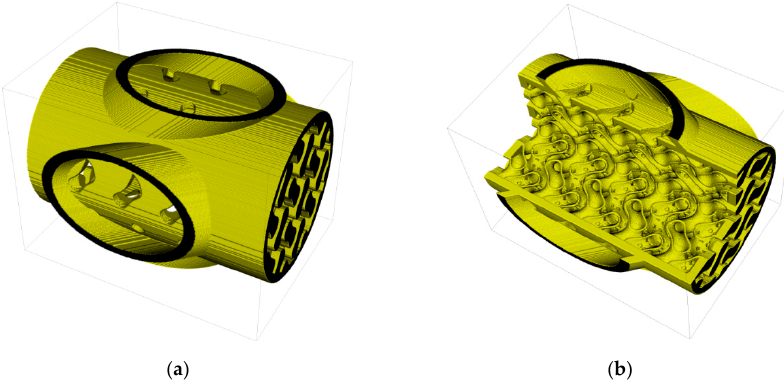
Figure 4. Housing of the gyroid structure ( a ) and sliced component ( b ).